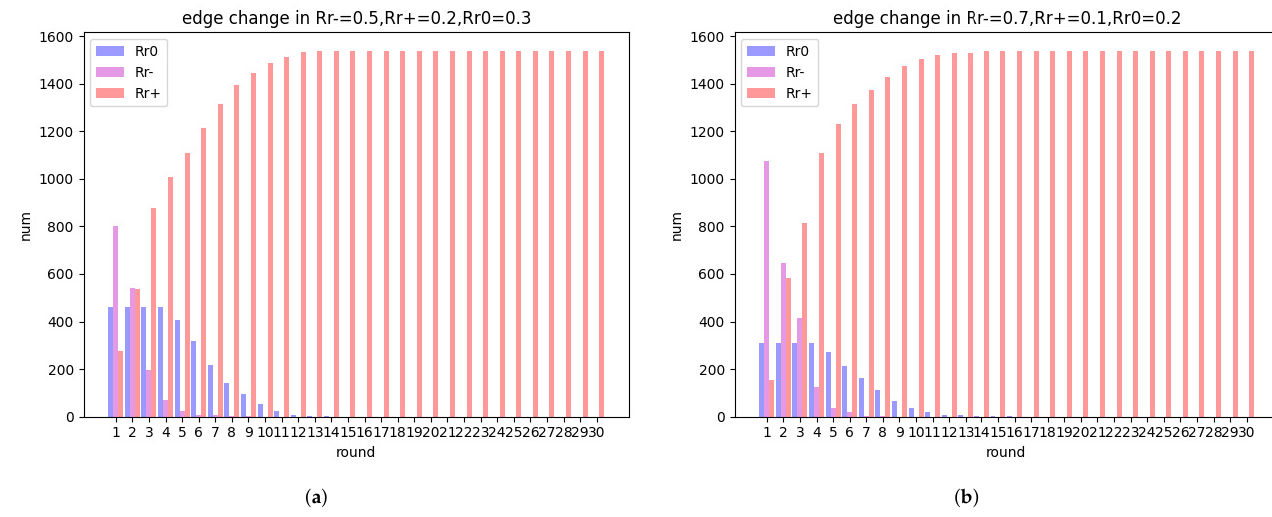
Figure 17. Changes in the number of various edges: ( a ) edges change in R r − = 0.5, R r + = 0.2,